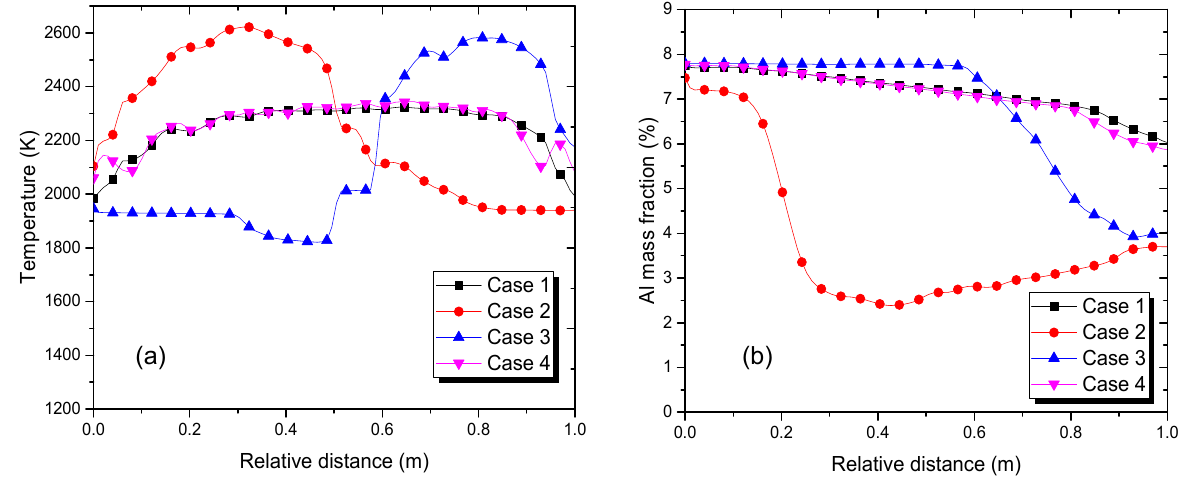
Figure 10. ( a ) The temperatures and ( b ) Al mass fractions for the top centerline.